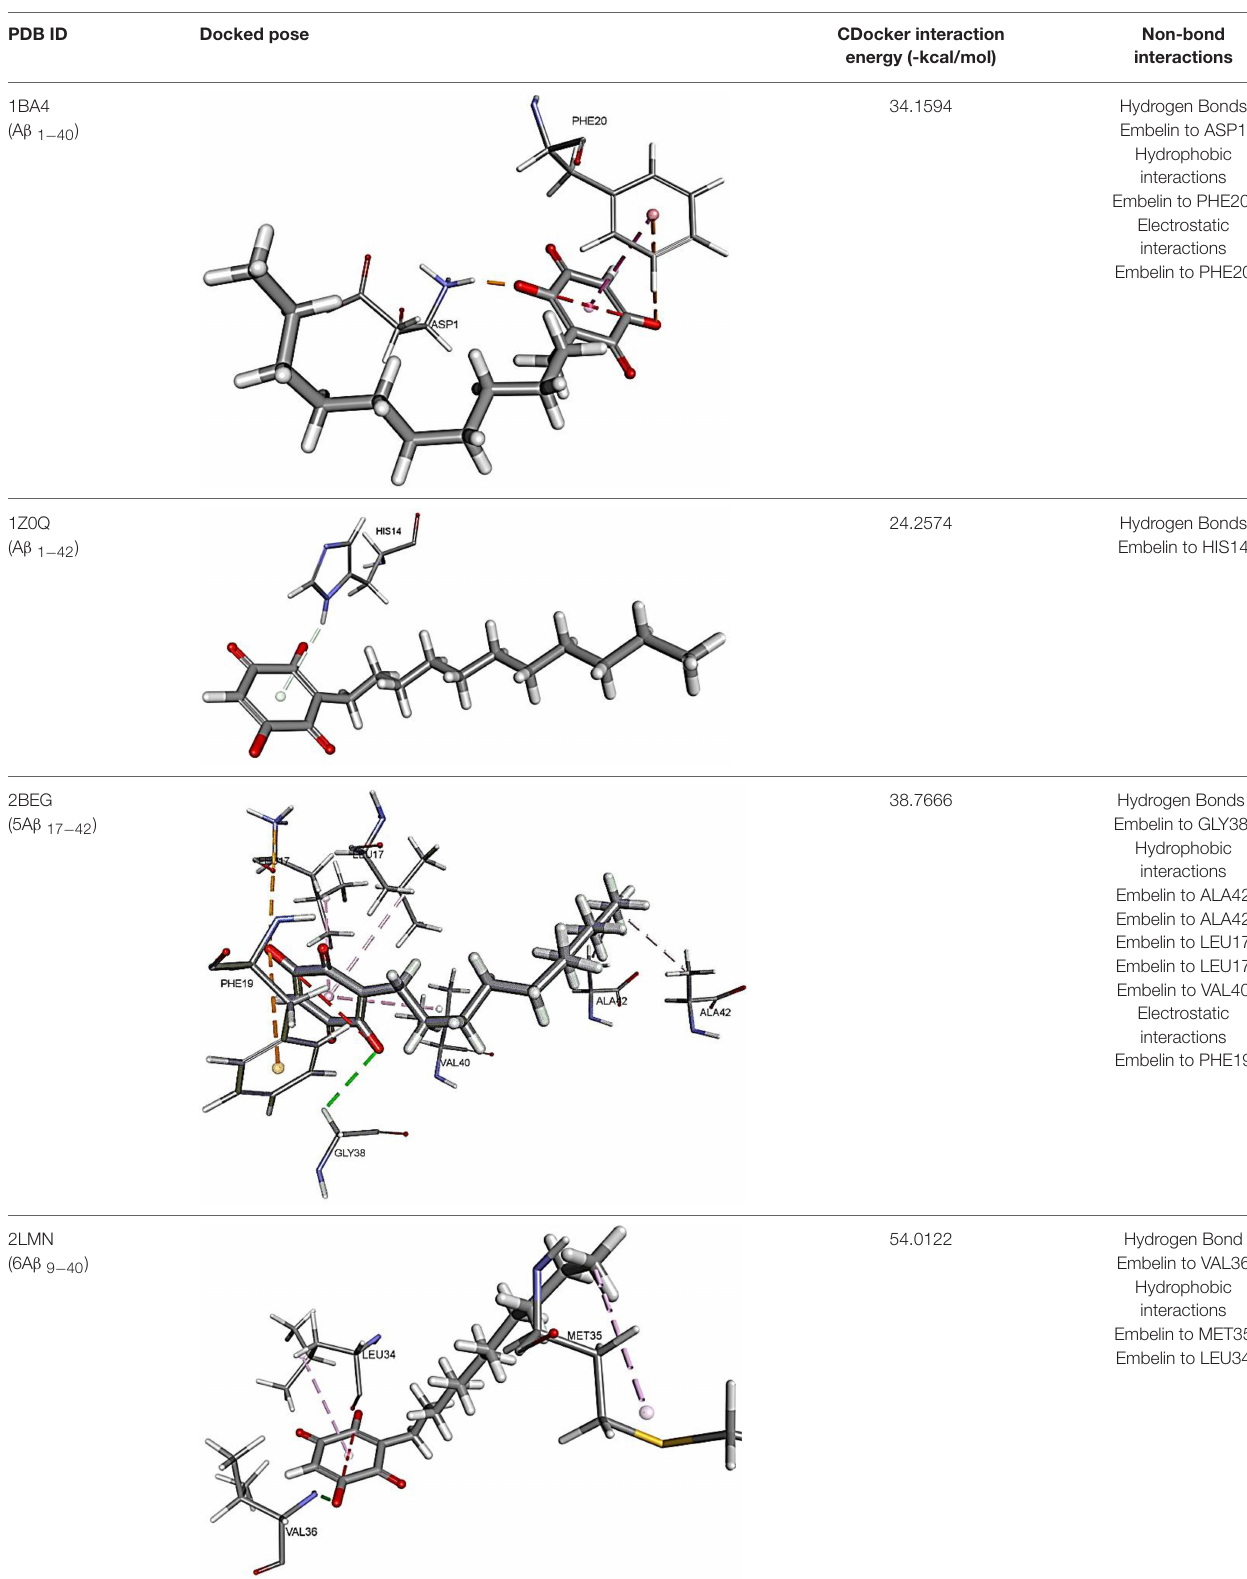
TABLE 3 | Binding modes of embelin docked to A β active sites (monomers and